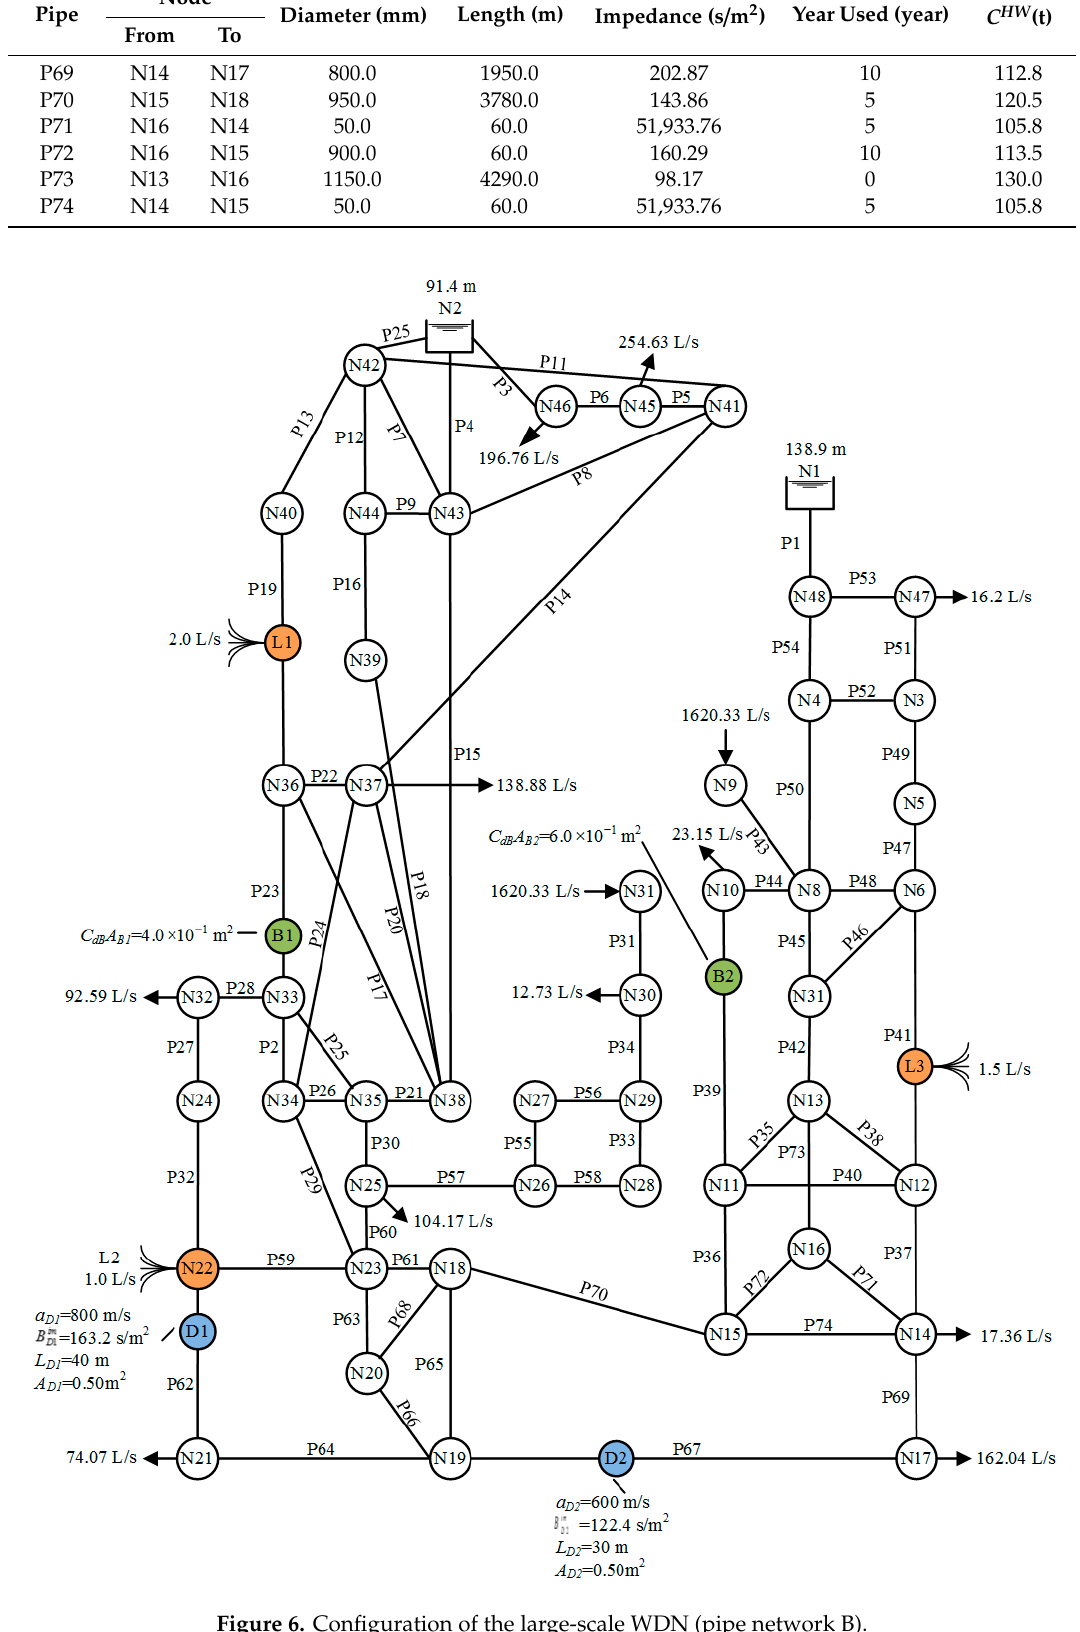
Figure 6. Configuration of the large-scale WDN (pipe network B) .